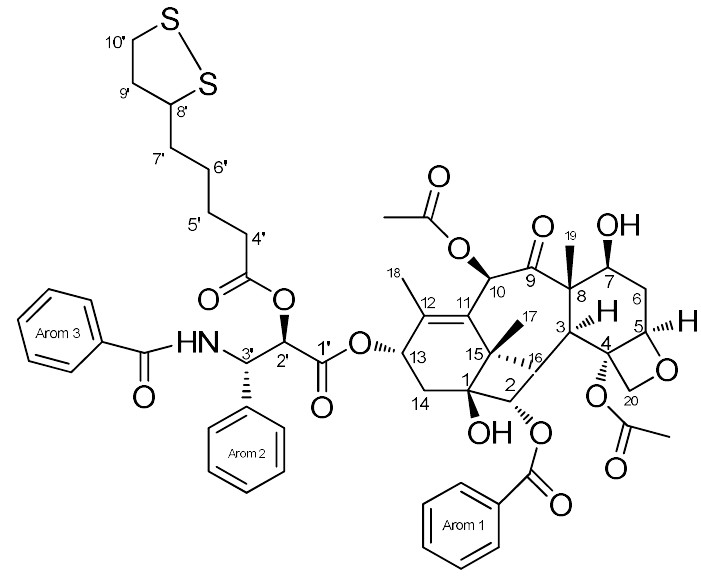
Figure 3. Chemical structure of the IDD-1040. Molecular formula: C 55 H 63 NO 15 S 2 .